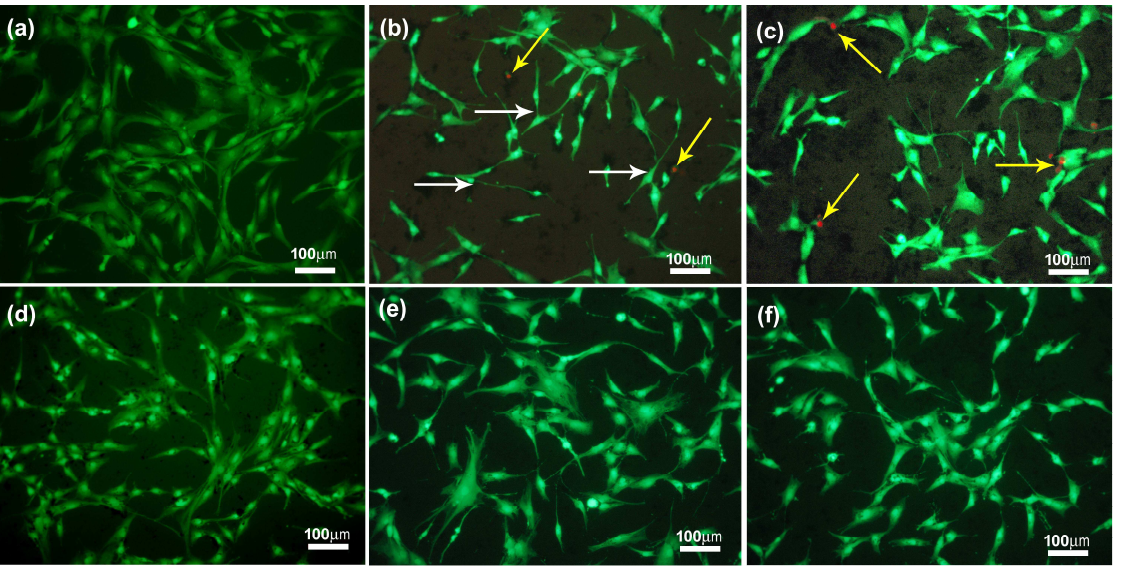
Figure 9. Merged microphotographs of human chondrocyte cell line (CHON-001) stained with calcein AM/propidium iodide grown on control (PS) ( a ) and eCNF750 ( b ), eCNF1000 ( c ), eCNF1500 ( d ), eCNF 1750 ( e ) and eCNF2000 ( f ).